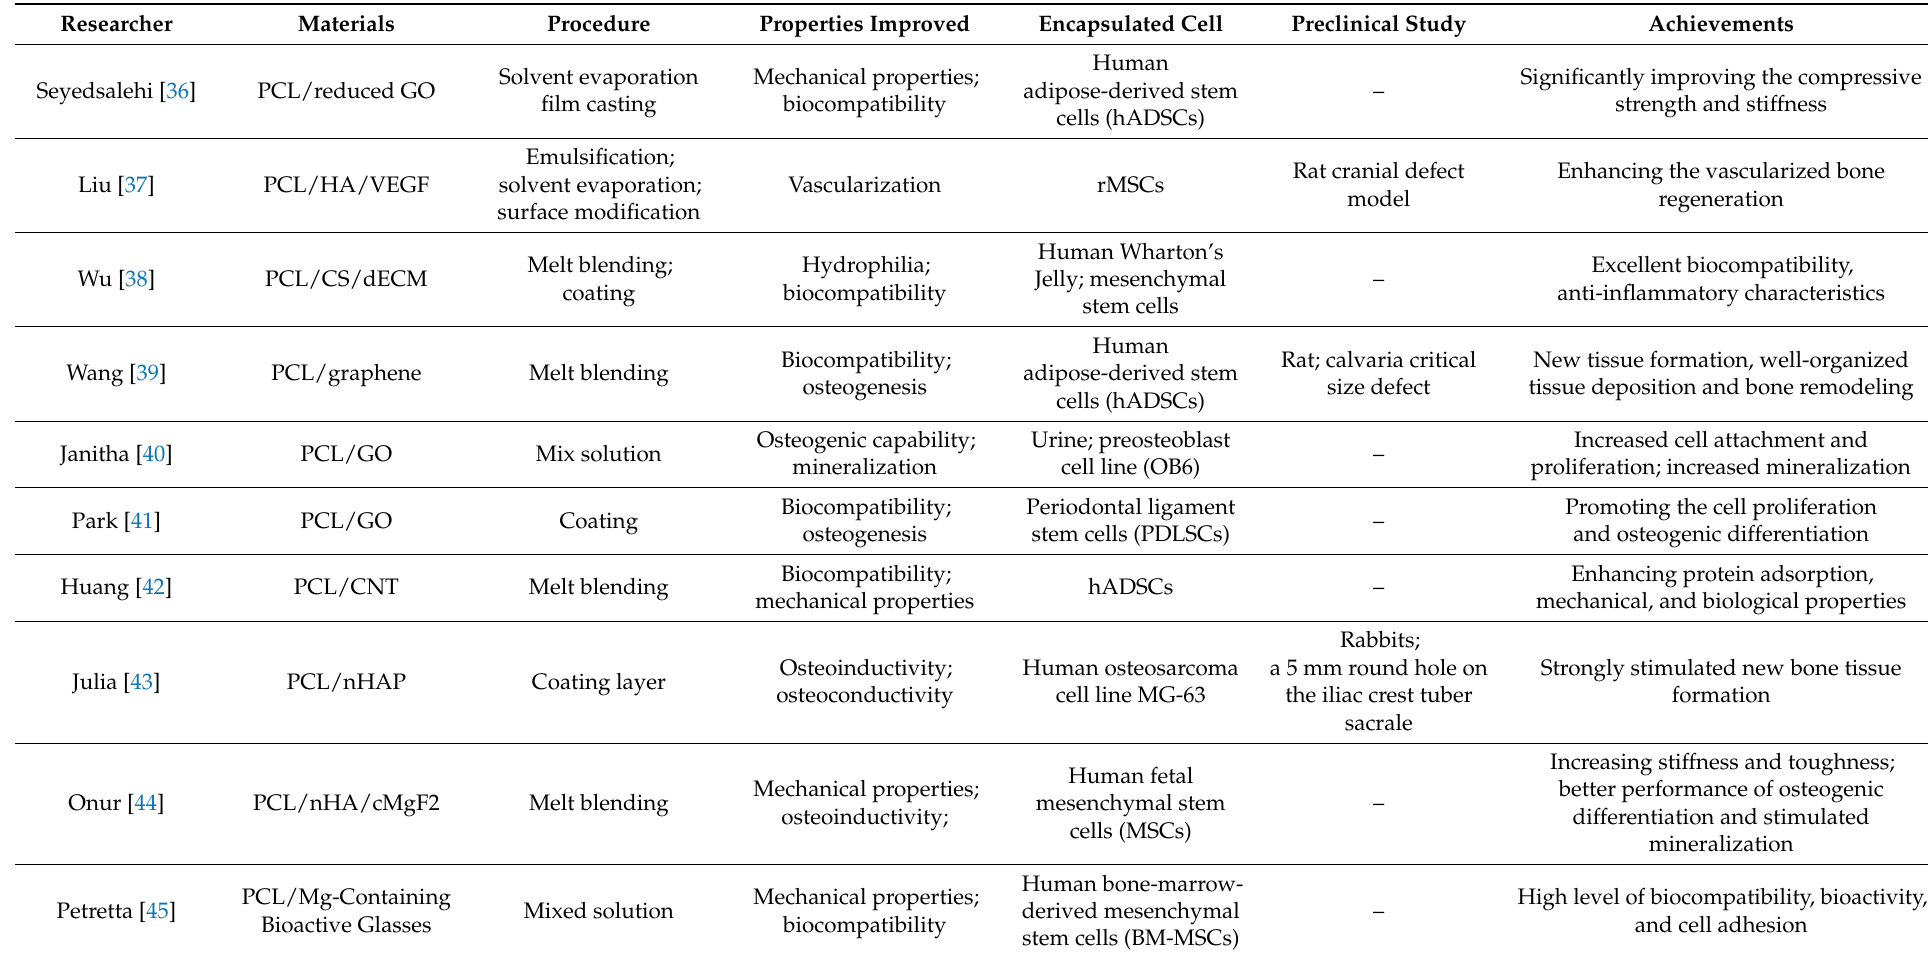
Table 2. A summary of recent research and advances in PCL-based composite scaffolds and property